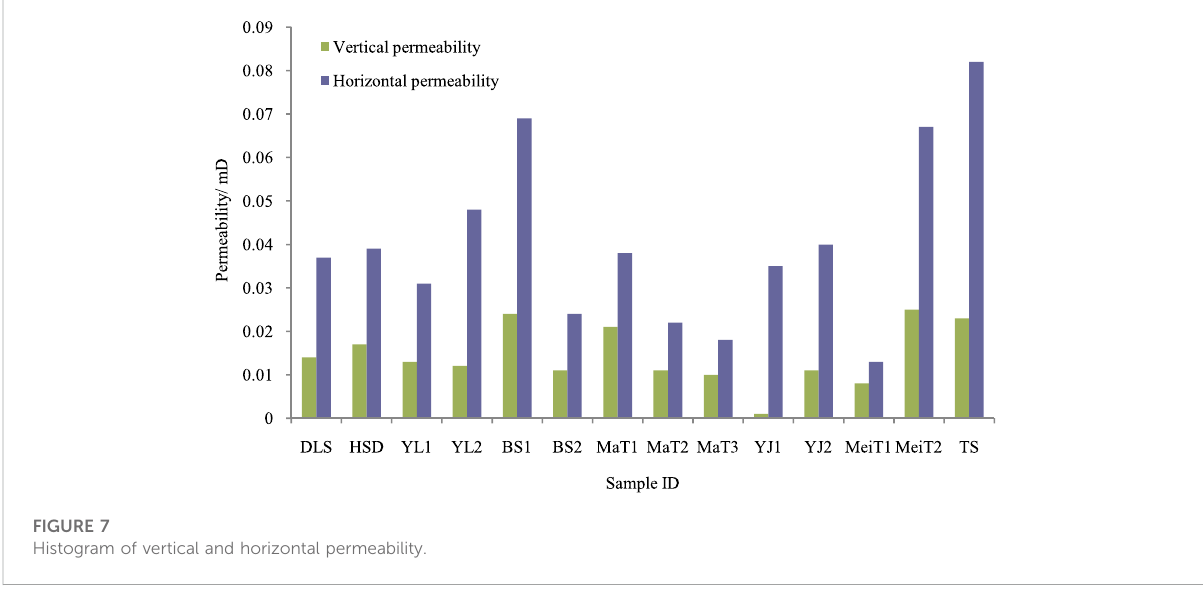
FIGURE 7 Histogram of vertical and horizontal permeability.